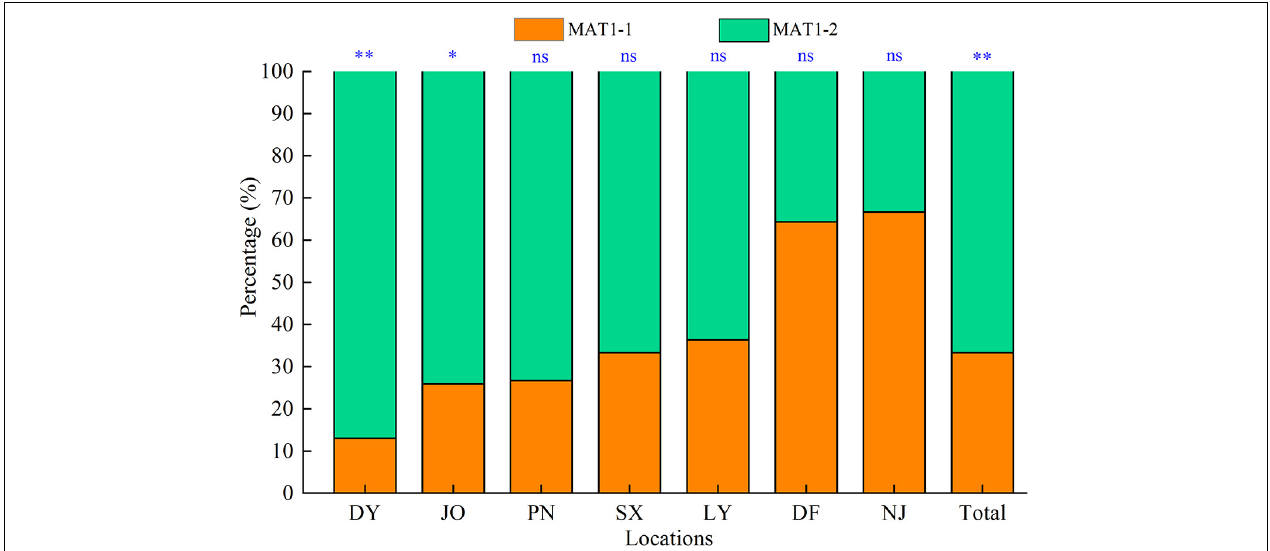
FIGURE 1 | Distribution of the two mating types (MAT1-1 and MAT1-2) of Setosphaeria turcica in Fujian Province, China. DY, JO, PN, SX, LY, DF, and NJ represent S. turcica isolates collected from the Dongyou (23 isolates), Jian’ou (27), Pingnan (15), Songxi (18), Longyan (11), Dongfeng (14), and Nanjing (9) regions of Fujian Province, respectively. The mating type of 117 S. turcica isolates was determined based on multiple PCR analyses using two mating type-specific primer pairs. ∗ : P < 0.05; ∗∗ : P < 0.01; ns: no significant difference. TABLE 1 | The distribution of mating types of Setosphaeria turcica within single leaves sampled from three locations (eight fields), identified based on multiple polymerase chain reaction analyses using two mating type-specific primer pairs. Populations Years of collection Locations Geographical and cropping characterizations No. of corn cultivars Mating types Total